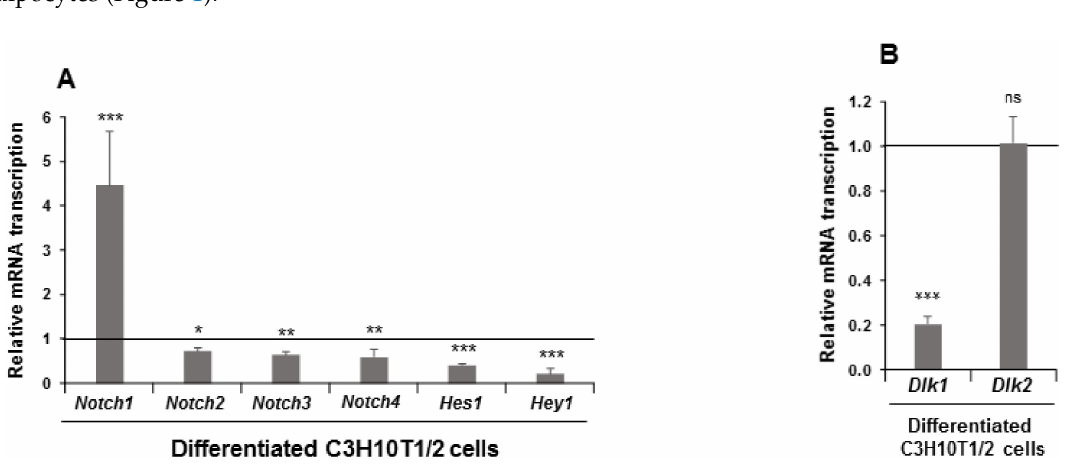
Figure 1. Expression of Notch family genes in di ff erentiated C3H10T1 / 2 cells. Relative mRNA transcription levels of Notch , Hes1 (hairy and enhancer of split 1), and Hey1 (hairy and enhancer-of-split related with YRPW motif 1) ( A ) and Dlk (DELTA-like homologs) ( B ) genes in seven-day di ff erentiated C3H10T1 / 2 cells. Data from qRT-PCR (quantitative reverse transcription-polymerase chain